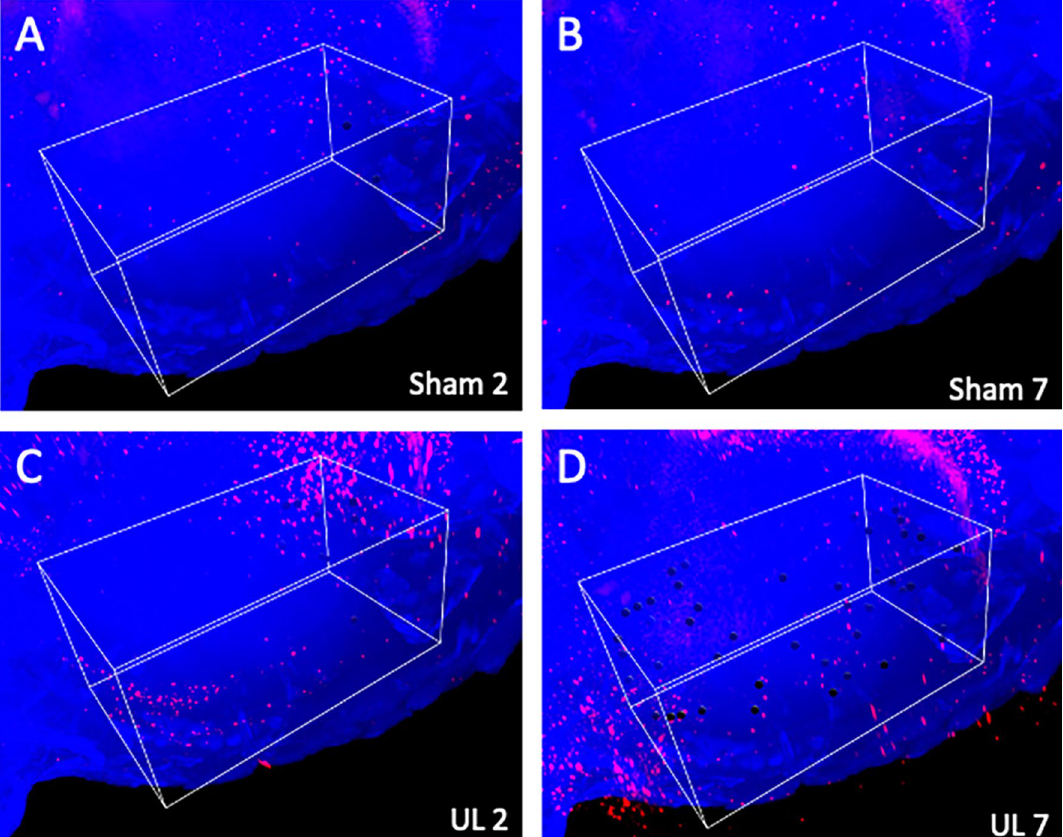
Figure 5. Magnified images of S1. Representative images of activated neurons in box-shaped 3D ROIs set in S1. The black dots indicated automatically-selected activated neurons inside the 3D ROIs. ( A ) Images obtained 2 days after sham surgery. ( B ) Images obtained 7 days after sham surgery. ( C ) Images obtained 2 days after unilateral (left) labyrinthectomy (UL). ( D ) Images obtained 7 days after UL.